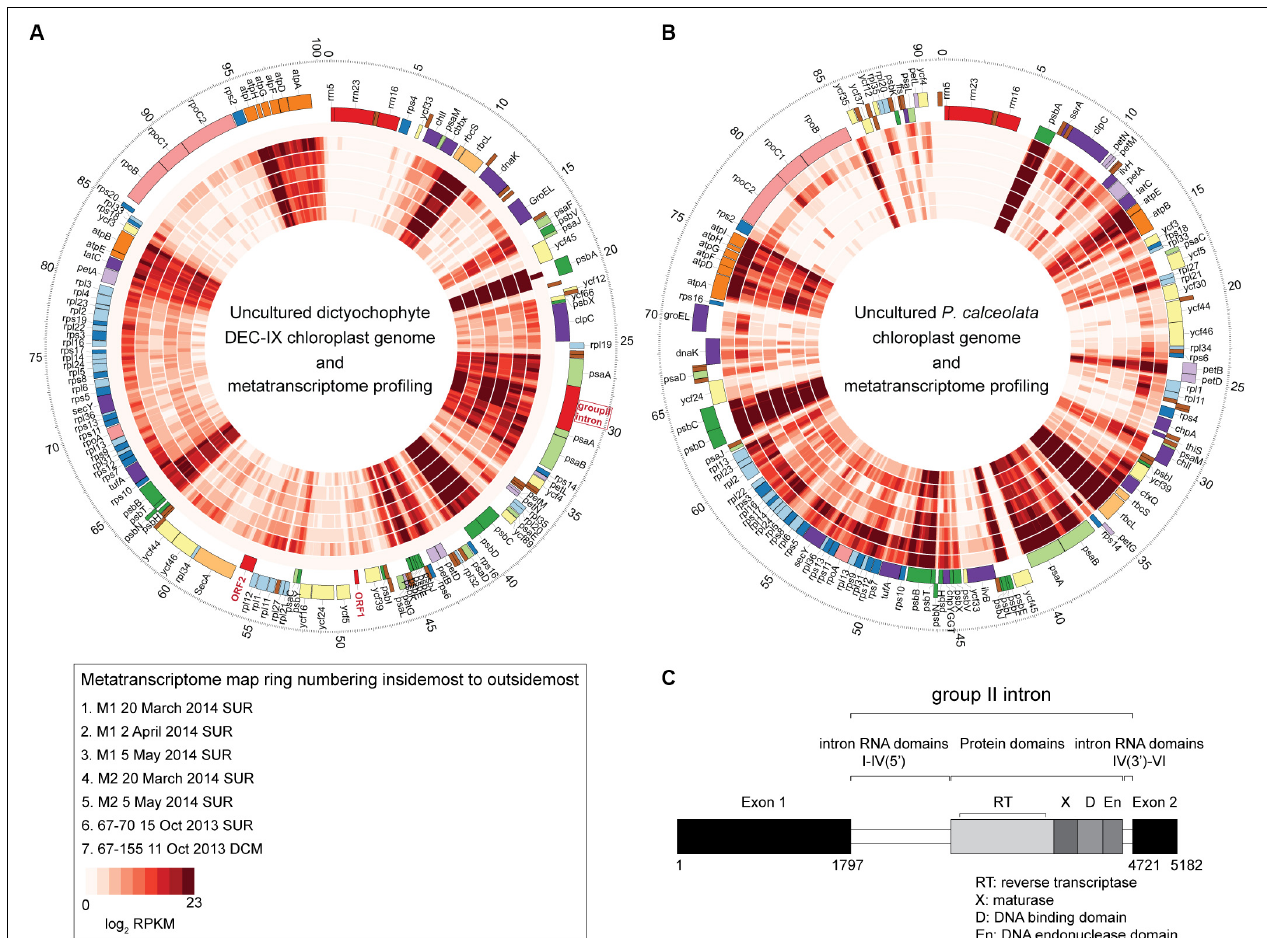
FIGURE 5 | The complete chloroplast genome of (A) uncultured dictyochophyte DEC-IX (B) and wild P. calceolata (Worden et al., 2012), and transcriptional activity in the ENP. Recruitment of metatranscriptomic reads (inner layers) at ≥ 99% nucleotide identity shown as mapped reads binned at 100 bp increments and log2 transformed for the heat plots which reflect the normalized transcripts. While the metatranscriptomes were unreplicated and therefore unsuitable for quantifying expression, qualitatively, similar patterns of expression were observed for genes present in both the DEC-IX and P. calceolata chloroplast genomes. All come from surface samples except the 67-155 metatranscriptome (100 m, DCM). Outermost ticks represent kilobase pairs (chloroplast genome size). (C) Structure of the psaA gene group II intron, showing upstream and downstream exons, intron domains and conserved IEP consisting of a reverse transcriptase (RT), a maturase domain (X), a DNA-binding domain (D) and an endonuclease domain